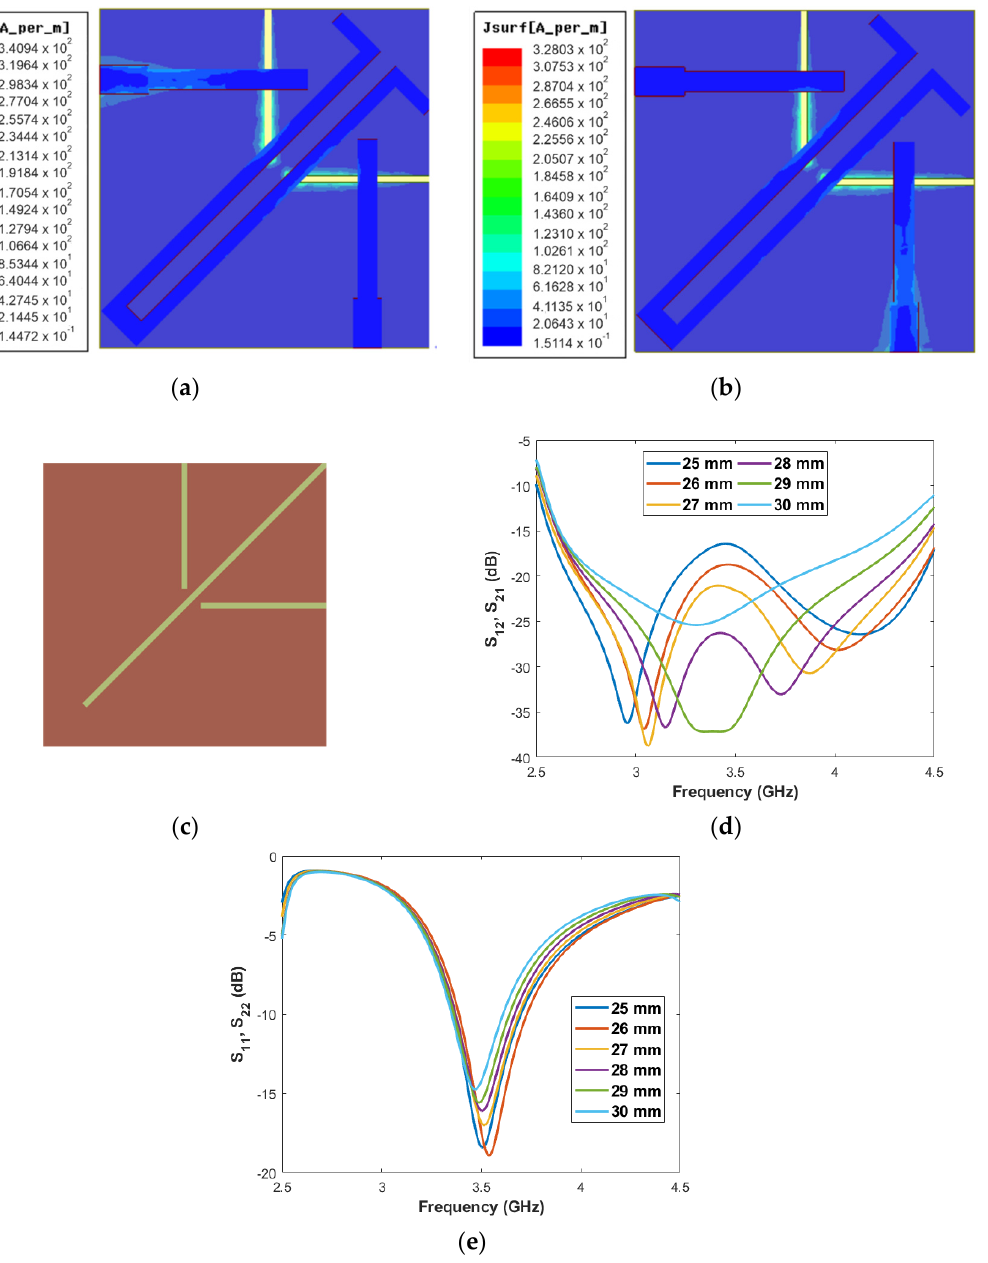
Figure 6. Diagonal slot design of the ground plane to improve isolation: surface current densities for ( a ) port 1 and ( b ) port 2; ( c ) representation of the ground plane after insertion of the slot, ( d ) S 12 /S 21 and ( e ) S 11 /S 22 results for different values of the slot length. Therefore, the selected slot length value is 29 mm, because it provides the highest isolation between the ports.